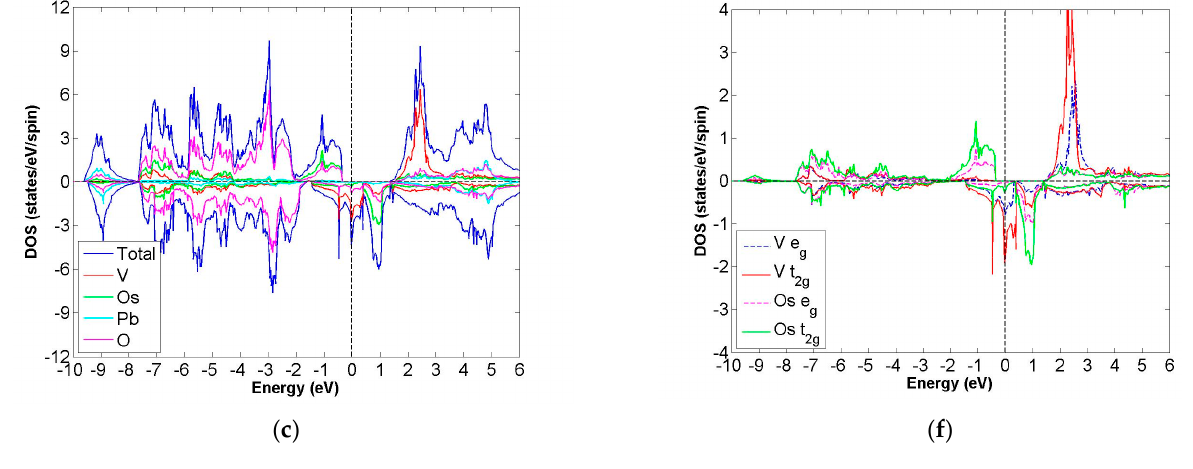
Figure 8. Under GGA + U (U of Zr, Hf, V and Os set up as 2) schemes, the calculated total and partial DOS values of ( a ) Pb 2 ZrOsO 6 , ( b ) Pb 2 HfOsO 6 and ( c ) Pb 2 VOsO 6 and the partial DOS of e g and t 2g spin orbitals for ( d ) Zr and Os and ( e ) Hf and Os and ( f ) V and Os.